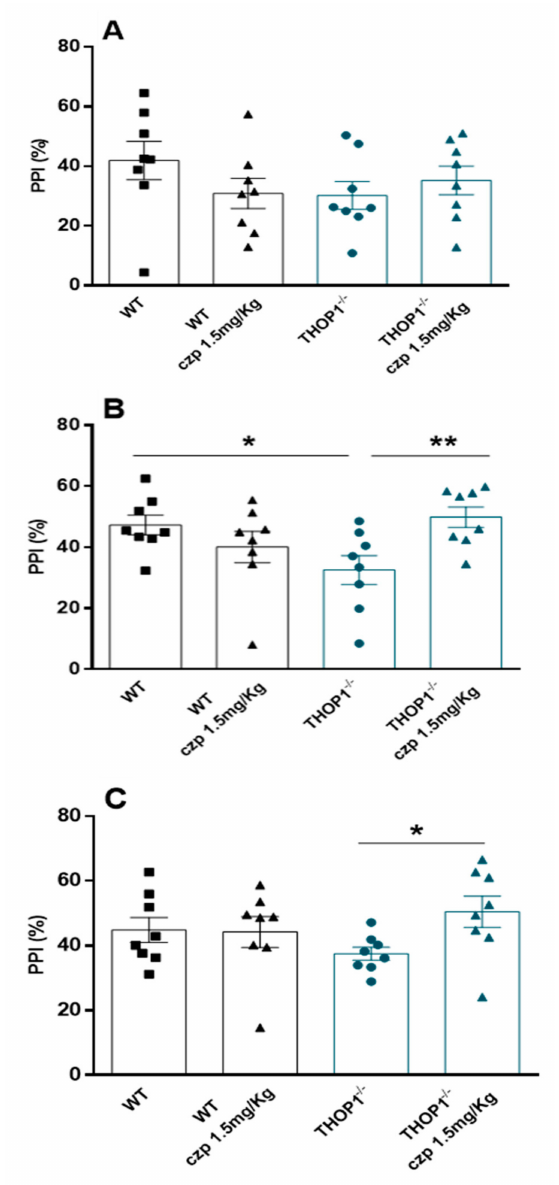
Figure 7. Prepulse inhibition of startle test. Percentage of prepulse inhibition of startle for each prepulse (PP) intensity: 75 dB ( A ), 80 dB ( B ), and 85 dB ( C ). Note that clozapine (czp) induced a significant increase in PPI response of THOP1 - / - at both 80 and 85 dB (B,C), whereas it did not modify the response of WT mice (A–C). Results are expressed as mean ± S.E.M. Statistical significance was determined by one-way ANOVA test. Tukey’s post hoc: * p < 0.05; ** p < 0.01). n = 8. per